Question: How would you classify this visualization?
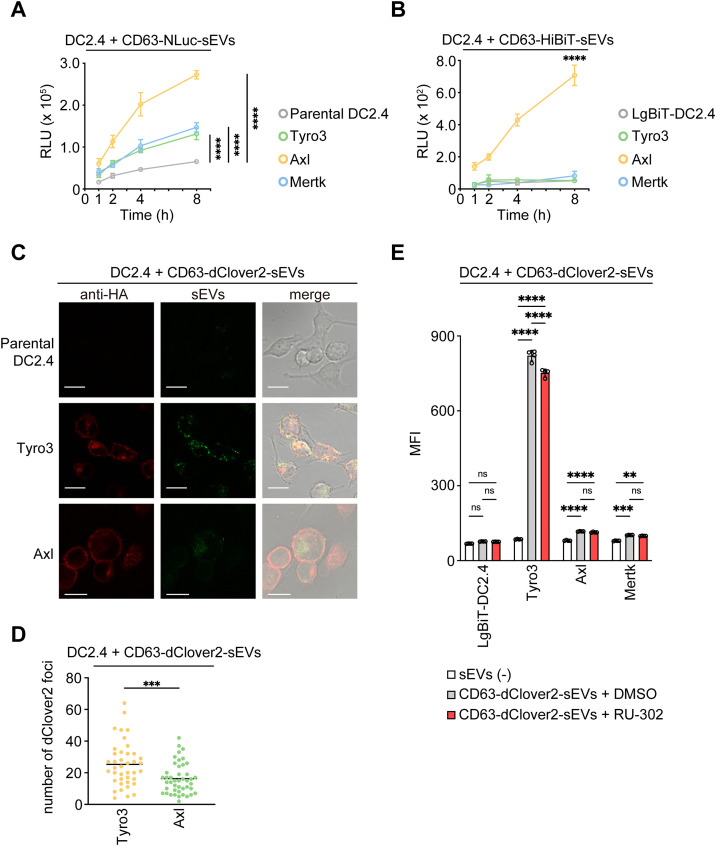
Answer: bar